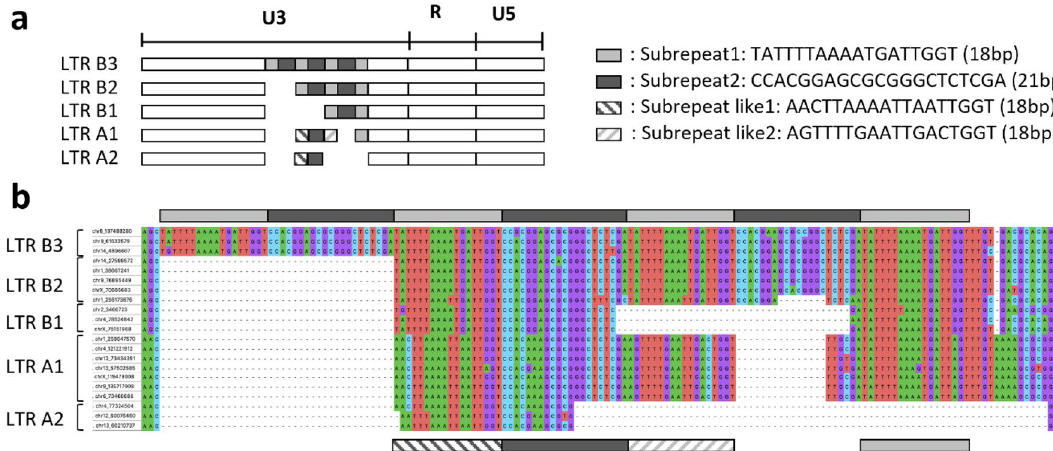
Figure 4. Structure for detecting non-reference long terminal repeats (LTRs) in the U3 region. ( a ) Porcine endogenous retroviruses (PERV)-LTR structure. The PERV-LTRs were classified into types B and A according to the patterns of their repeat sequences at 18 bp and 21 bp. Type B LTRs were divided into the subtypes LTR B1, LTR B2, and LTR B3 based on the number of repeats in their sequences. Type A LTRs were divided into the subtypes LTR A1 and LTR A2. ( b ) Type B repeat sequences are shown in light and dark gray at the top of the figure. Type A repeat sequences are shown in dark gray and stripes at the bottom of the figure. Nucleotides are denoted in green (A), blue (C), purple (G), and red (T). From top to bottom, the labels at left show the LTR loci chr8_137488280, chr9_61533579, chr14_4896607, chr14_27599572, chr1_38667241,